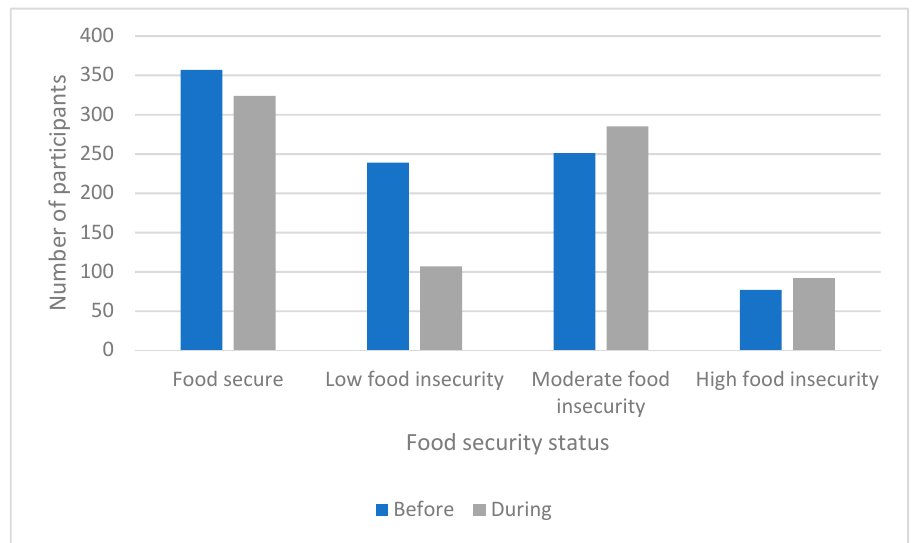
Figure 4 . Food security status among the households prior to and during the pandemic .